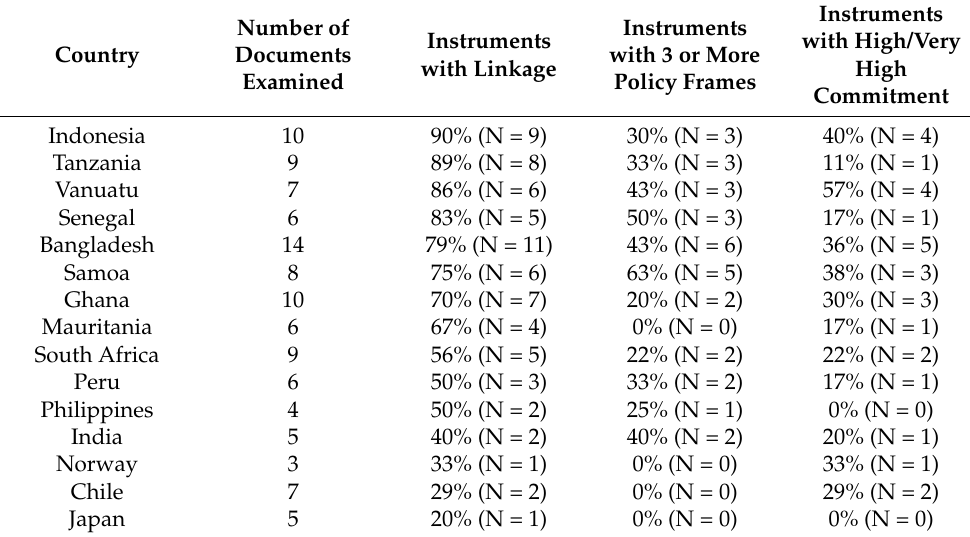
Table 7. Linkages and high level of commitment by